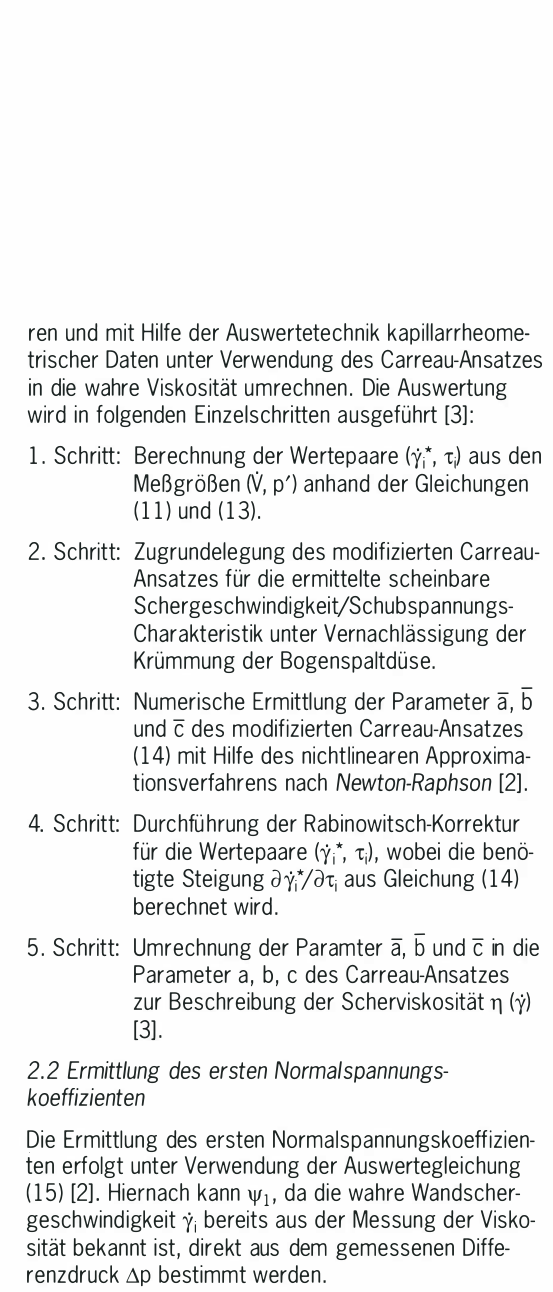
Fig.3: Curved slit